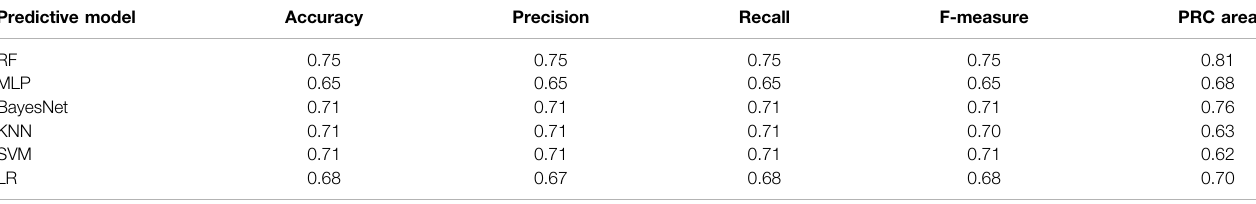
TABLE 2 | Comparison of predictive models for performance prediction of student ’ s second module assignments. Predictive model